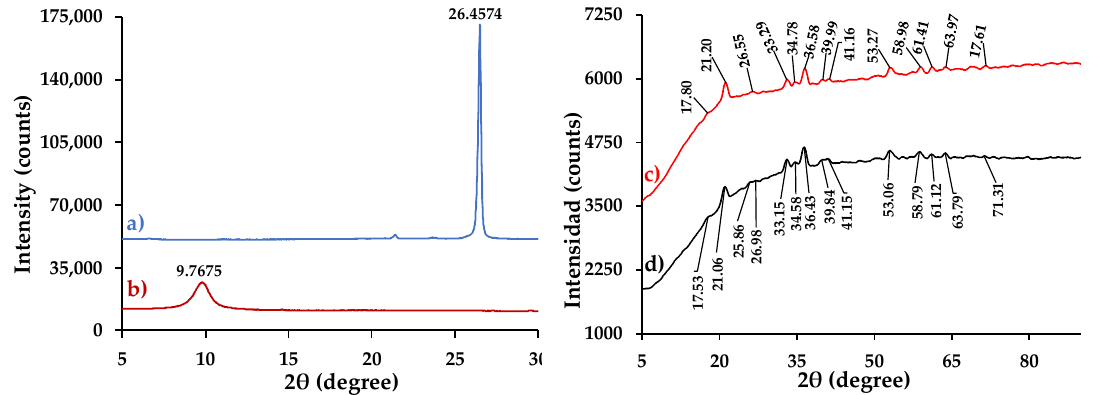
Figure 7. XRD patterns of ( a ) graphite, ( b ) GO, ( c ) α -FeOOH/rGO (composite 1), and ( d ) α -FeOOH/rGO (composite 2).